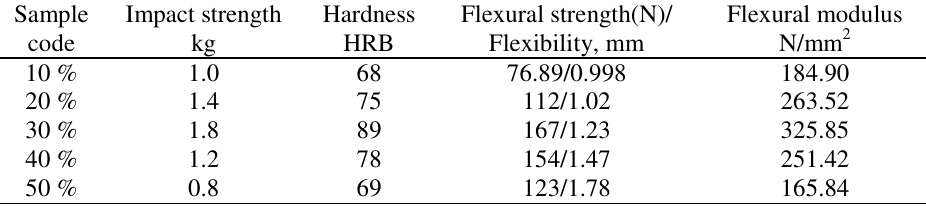
modulus for different ratios of UF resin